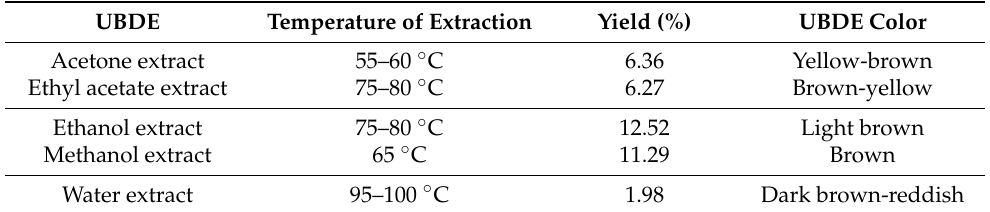
Table 1. The temperature values for refluxing at Soxhlet, extraction yield, and colors of UBDE using different solvents. UBDE Temperature of Extraction Yield (%) UBDE Color Acetone extract 55–60 ◦ C 6.36 Yellow-brown Ethyl acetate extract 75–80 ◦ C 6.27 Brown-yellow Ethanol extract 75–80 ◦ C 12.52 Light brown Methanol extract 65 ◦ C 11.29 Brown Water extract 95–100 ◦ C 1.98 Dark